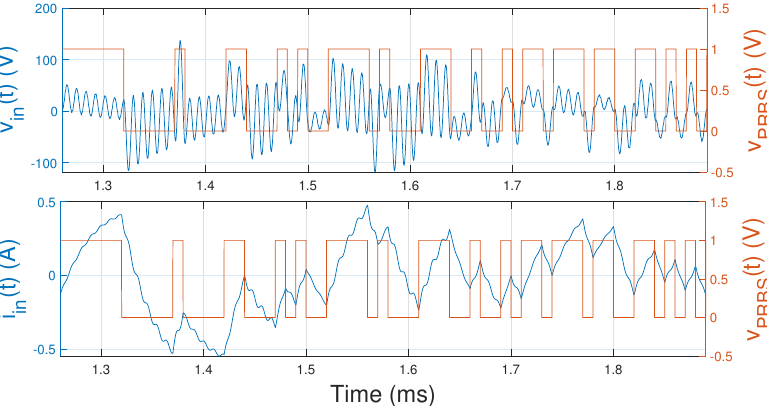
Figure 3. Typical Simulated Input Voltage and Input Current Waveforms.